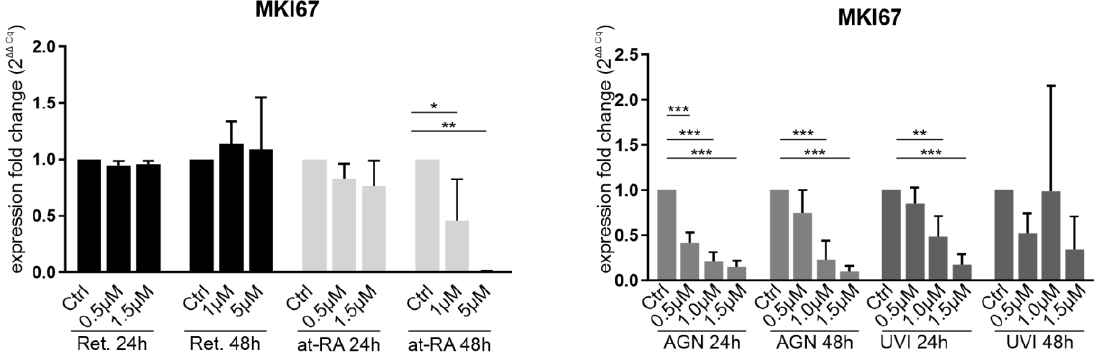
Figure 2. qRT-PCR analysis of the proliferation marker MKI67 (Ki67) in primary limbal epithelial cells treated with retinol (Ret), all trans-retinoic acid (at-RA), AGN 193109 (AGN), or UVI 3003 (UVI) for 24 h and 48 h. Expression fold changes (FC) were calculated relative to each control with the ΔΔCt method. * p ≤ 0.05; ** p ≤ 0.01; *** p ≤ 0.001; n = 3.